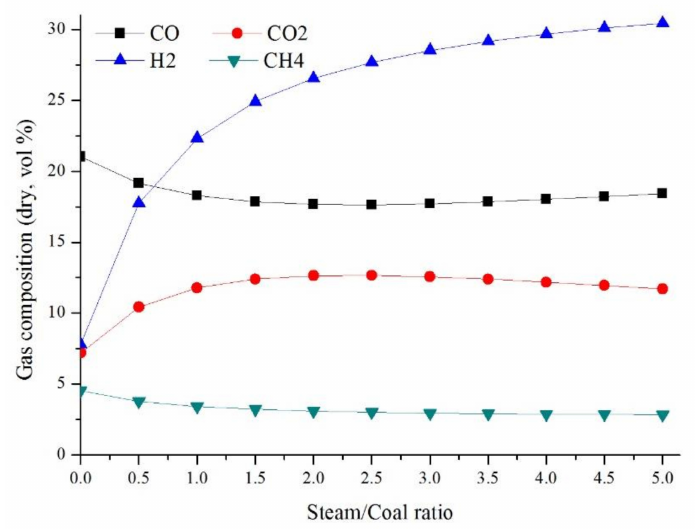
Figure 9. E ff ect of the steam to coal ratio on syngas composition (Simulation, ER = 0.2, T = 700 ◦ C). CCE (44.5%–72.7%), CGE (39.6%–83.1%), and LHV (5.13%–6.63 MJ / Nm 3 ) were all improved